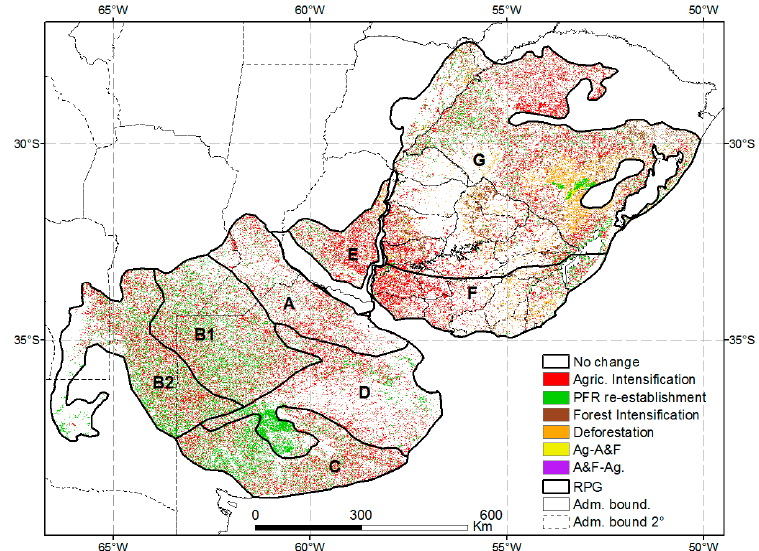
Figure 5. LULC change map in RPG between the periods 2001/2002 and 2012/2013. Agric. Intensification: agricultural intensification. PFR re-establishment: passage of agricultural categories to